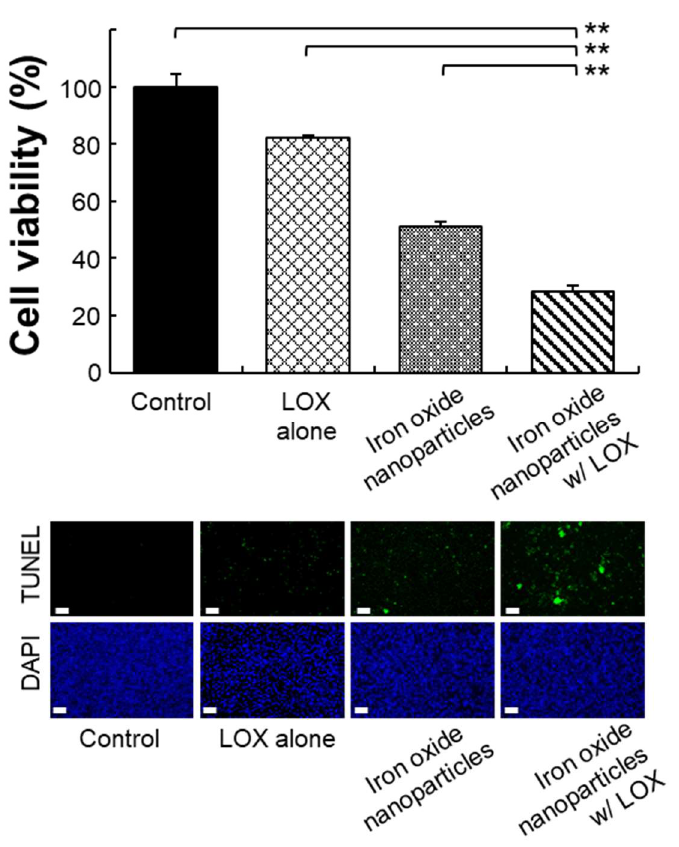
Figure 7. In vitro therapeutic effects. Cell viability of recombinant HT-1080 cells cocultured with M2 macrophages incubated with various treatments at pH 6.7 for 3 days as determined by MTS assays (** p < 0.0005, two-tailed unpaired Student’s t -test). The bars represent the mean ± standard deviation ( n = 4). Microscopic images of apoptotic cells stained by TUNEL assay (green fluorescence). Bars = 100 μm.